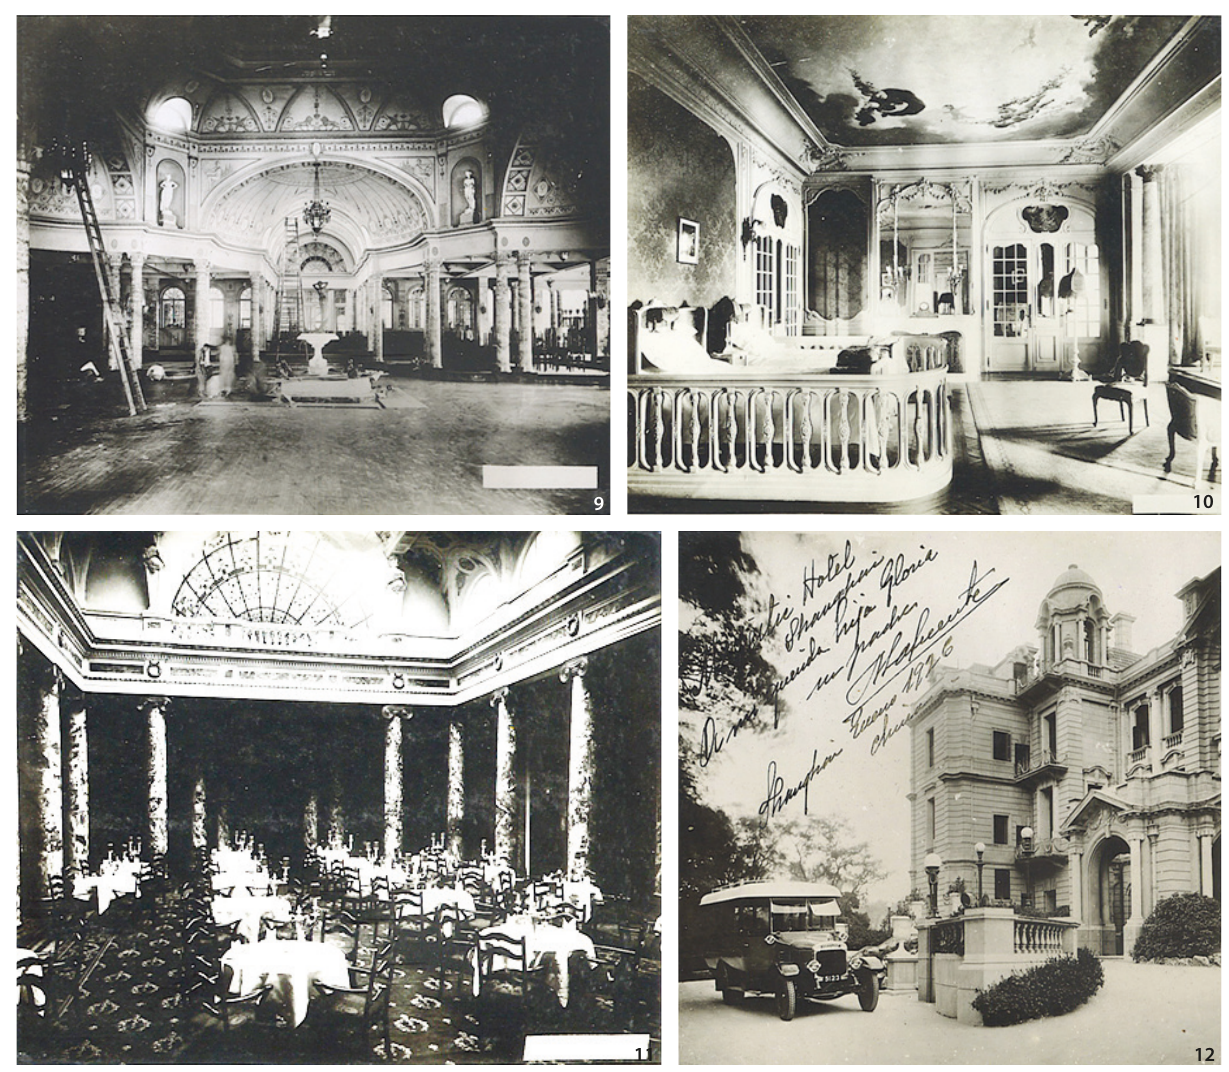
Figure 12 A view of the exterior of the Majestic Hotel with Lafuente’s original signature, 1926 (Source: Abelardo Lafuente´s Personal Portfolio from Lafuente Family Private Archive, cited in Leonardo Pérez